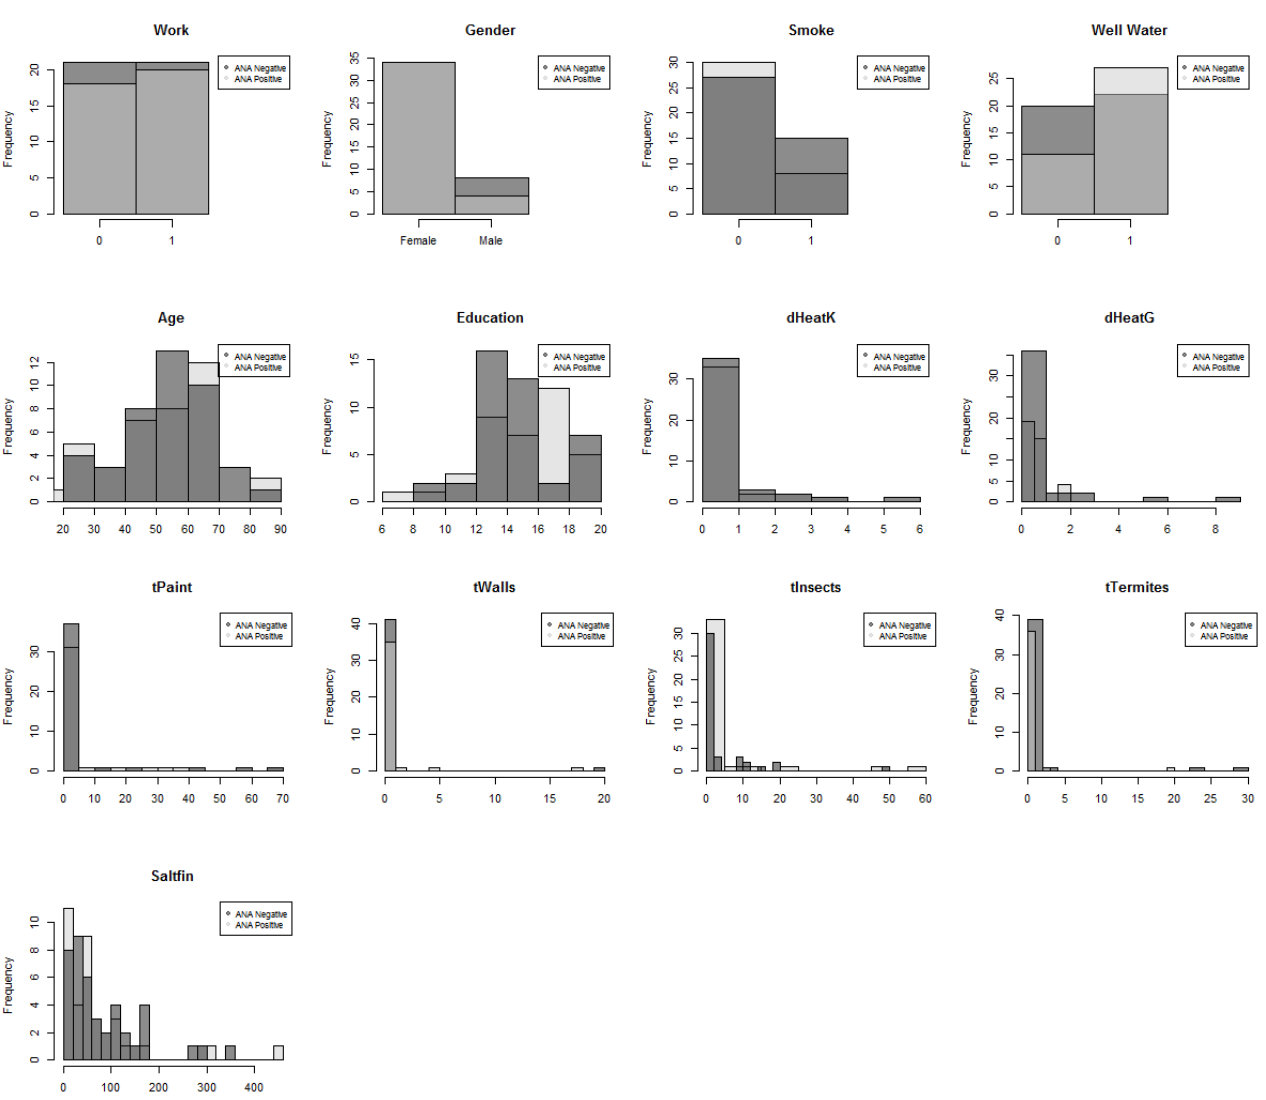
Figure 4. Distribution of personal variables with respect to ANA